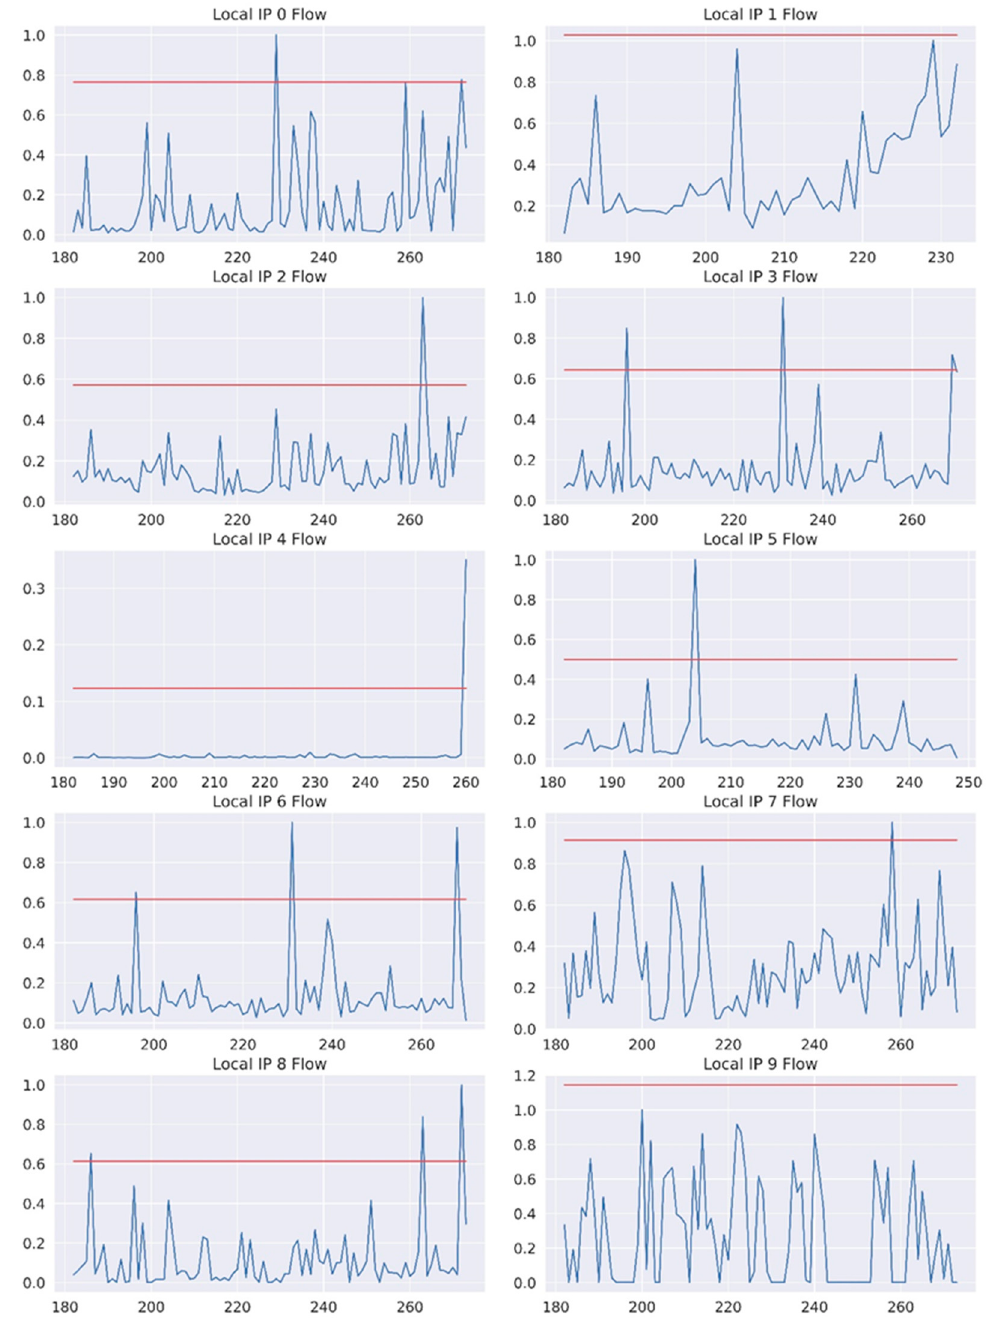
Figure 3. Traffic flow for all 10 IPs for the observation period.